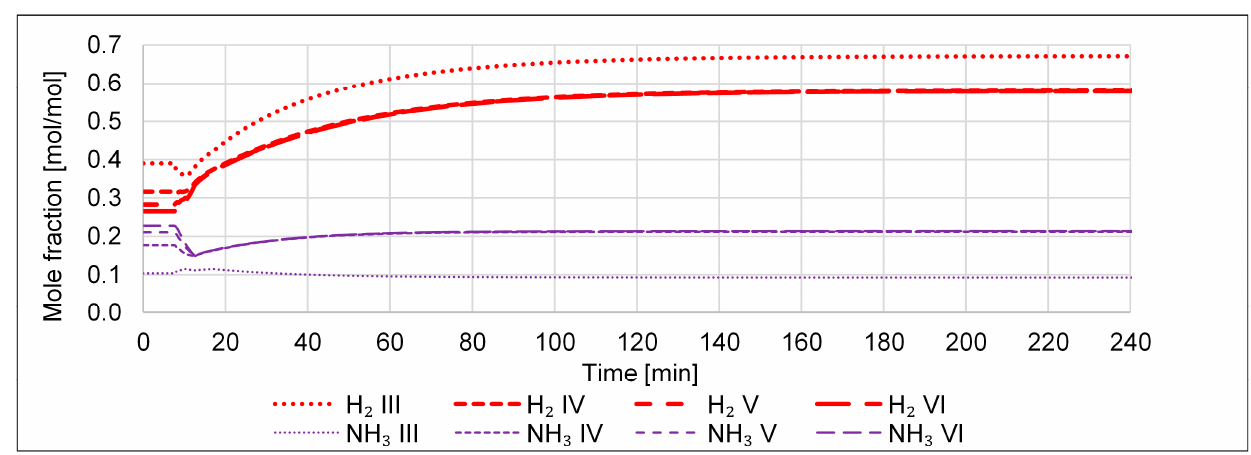
Figure 24 . Selected mole fractions of scenario (i). Figure 24. Selected mole fractions of scenario (i).